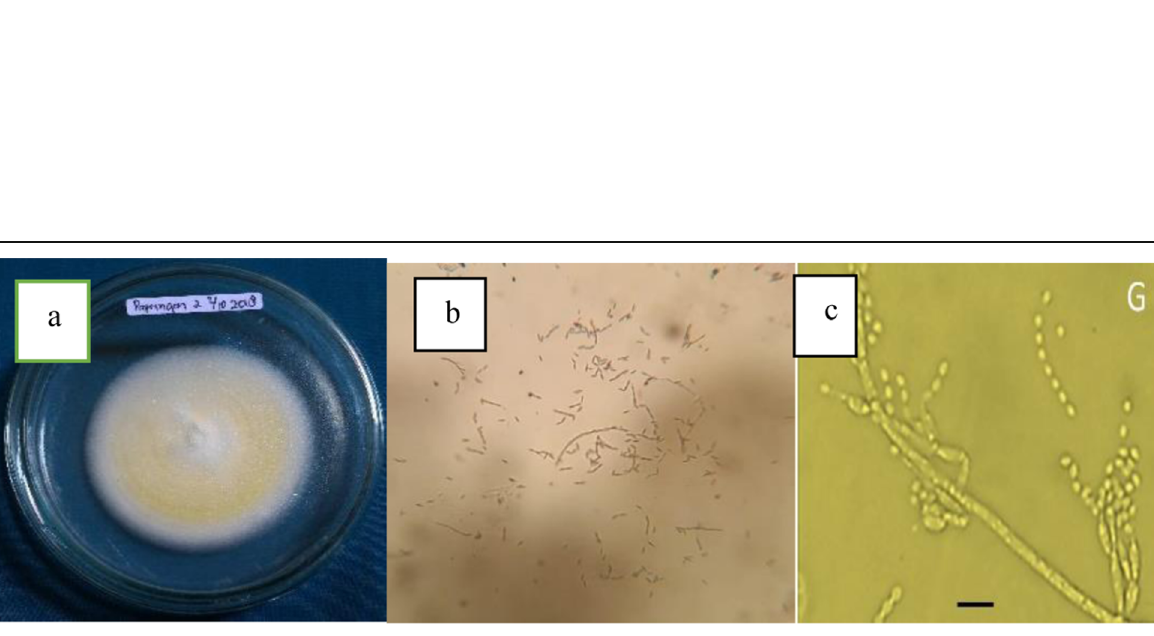
Fig. 3 a Pure cultures of 8 days old Papringan isolate (J60). b Paecilomyces sp. conidia (Minarni et al. 2020). c Paecilomyces javanicus conidia (Dong et al.